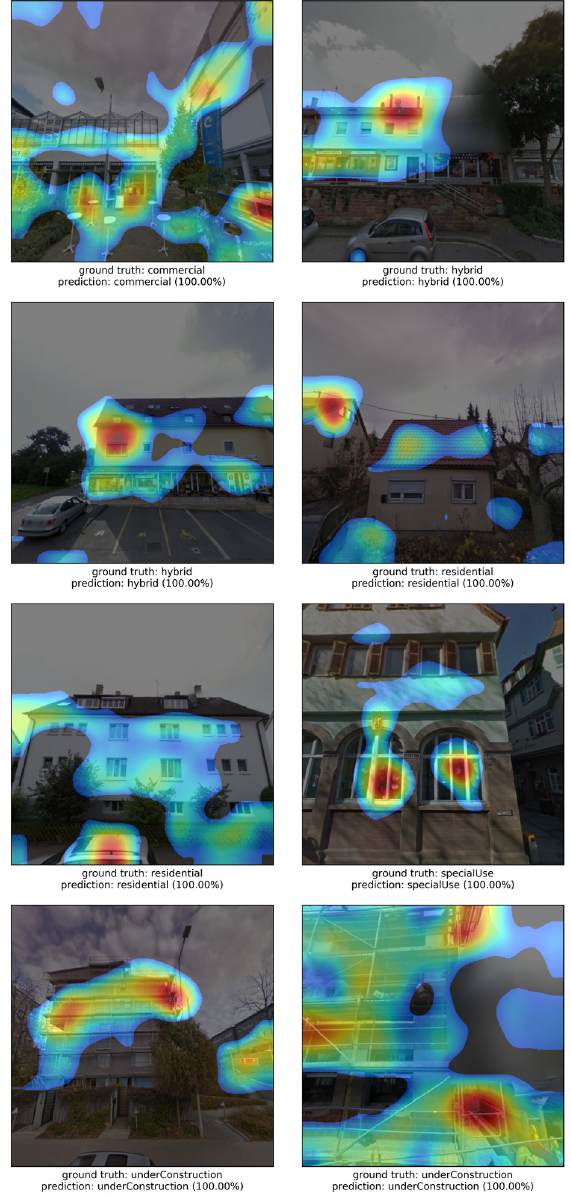
Figure 5. Correctly classified images with corresponding upsampled CAMs overlaid (multiclass